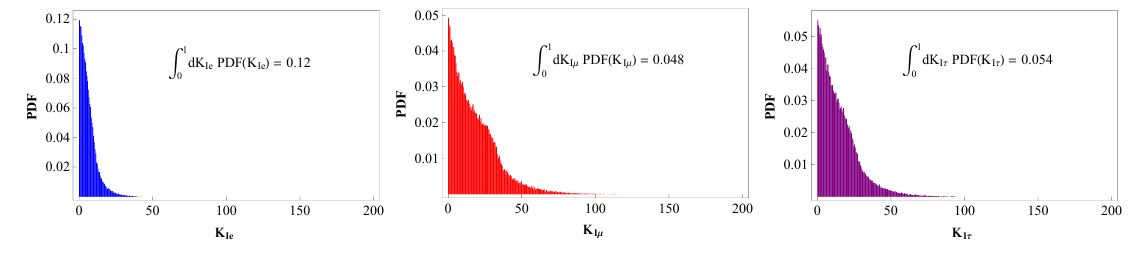
Figure 8. Same as in (cid:12)gure 6 but for m 1 = 0 : 01